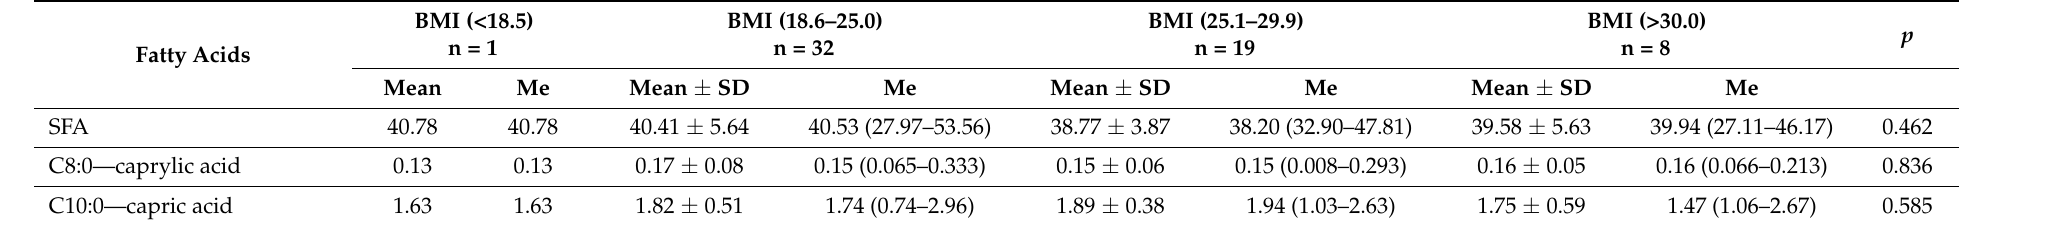
Table 7. Fatty acid content of breast milk (g/100 g of total FA) depending on